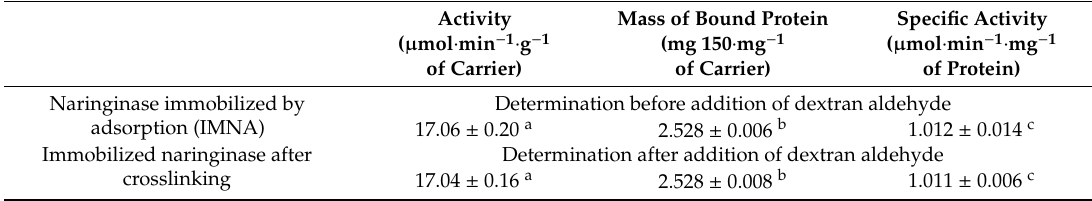
Table 3. E ff ect of dextran aldehyde crosslinking on the activity of bound